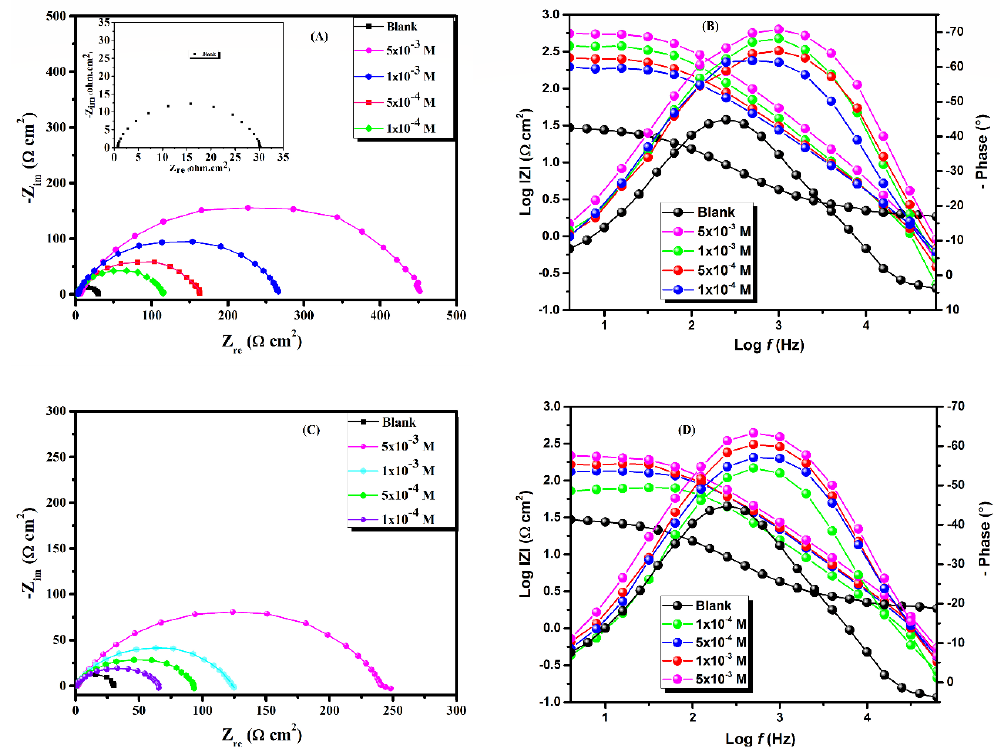
Figure 2. Nyquist curves and Bode and phase angle diagrams of MS in 1.0 M HCl without and with different concentrations of ( A,B ) 3-BIT and ( C,D ) 2-BIT at 303 K.